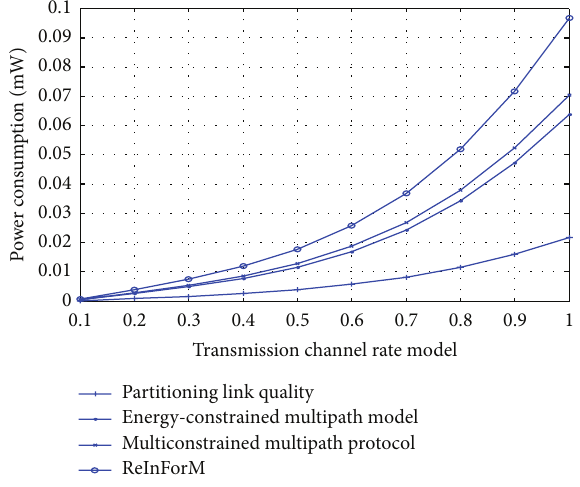
Figure 14: The power consumption